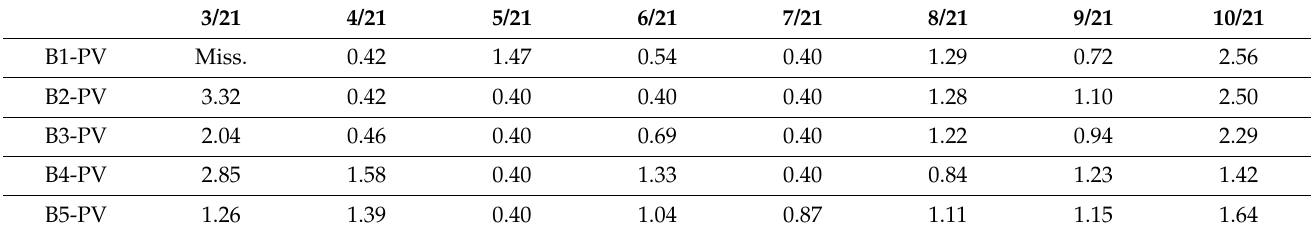
Table 17. Measured values for determining the minimum model value.